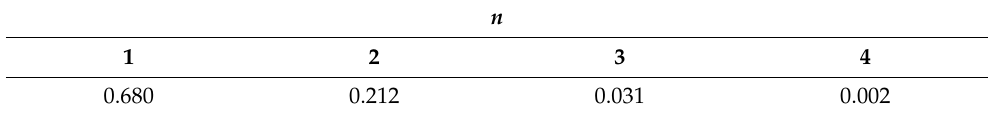
Table 8. Crowd reduction factors C ψ ( n ) .